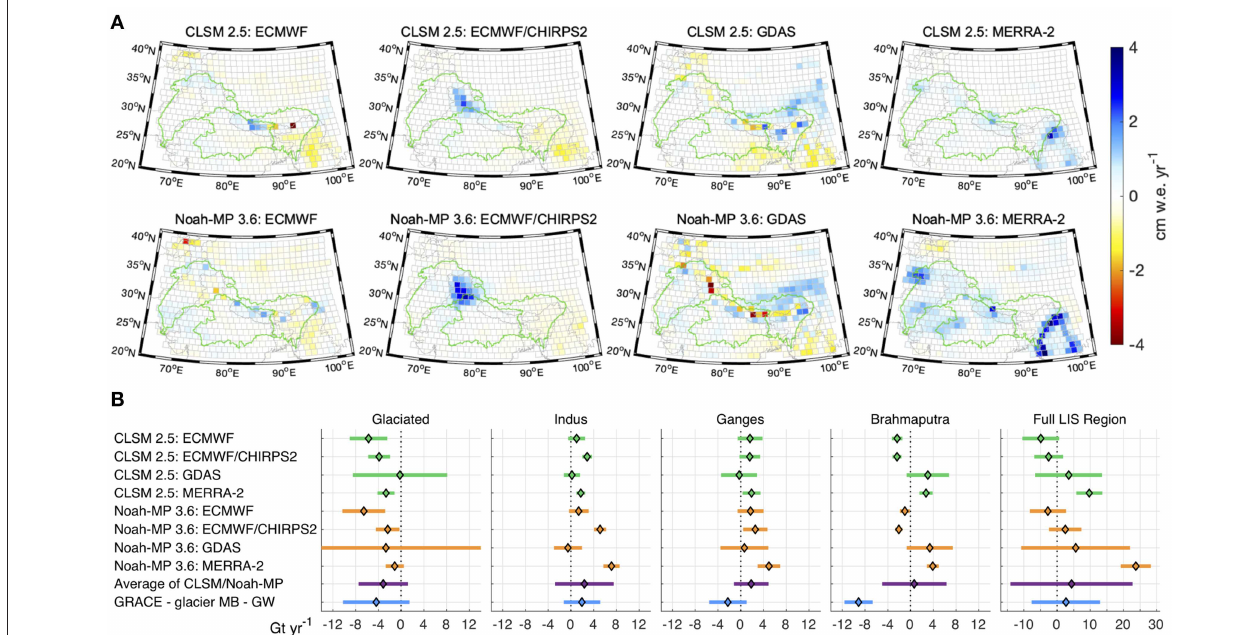
FIGURE 5 | (A) Trend maps for the eight different LIS outputs. (B) Summary of regional trend values for LIS outputs and GRACE with the glacier mass balance and groundwater signals removed (see Figure 1B for region definitions). Trends are computed for 2004–2016 to match the available LIS data. The CLSM/Noah-MP uncertainties represent 2 σ noise, the “Average of CLSM/Noah-MP” errors are twice the standard deviation of the eight CLSM/Noah-MP values, and the uncertainties for “GRACE - glacier MB - GW” include the 2 σ GRACE noise, GIA model error, and geocenter correction